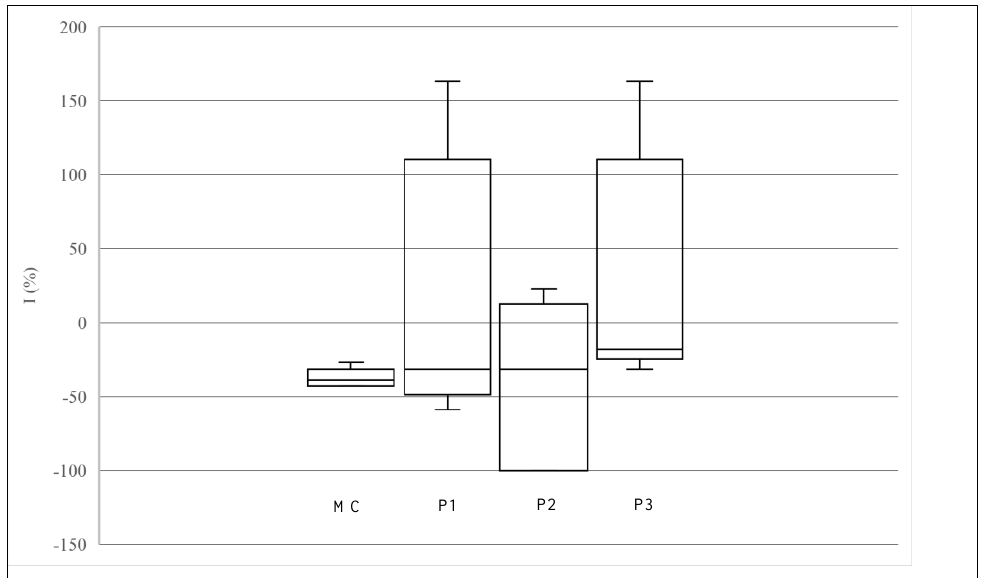
Figure 13. I index: comparison between the accuracy of measurement grids.